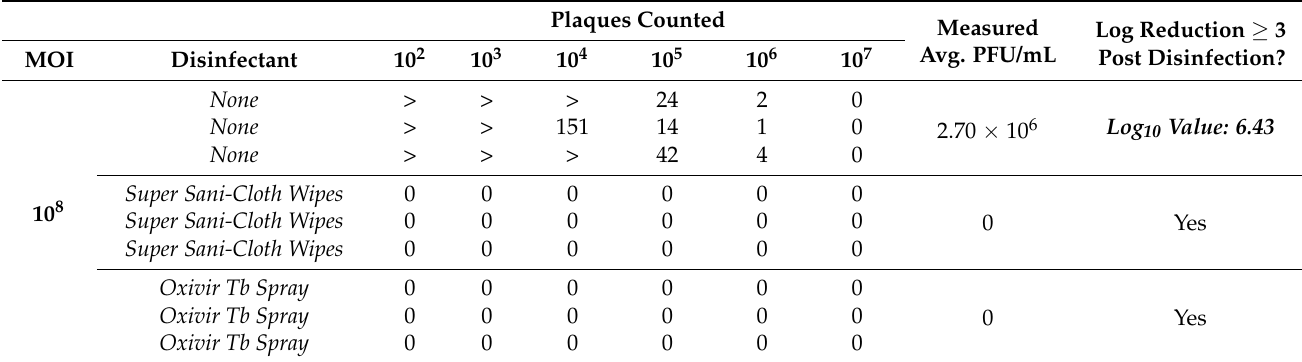
Table 3. Disinfection data for VSV-GFP 100 µ L spot on